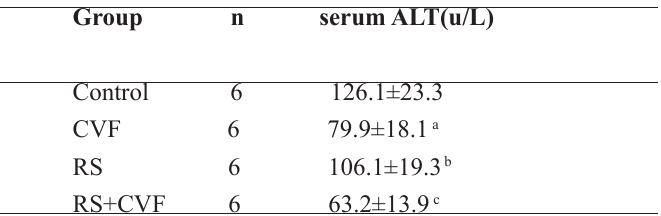
TABLE 2 - Liver function of rats receiving liver xenotransplantation and subsequent different treatments ( x ± S ).